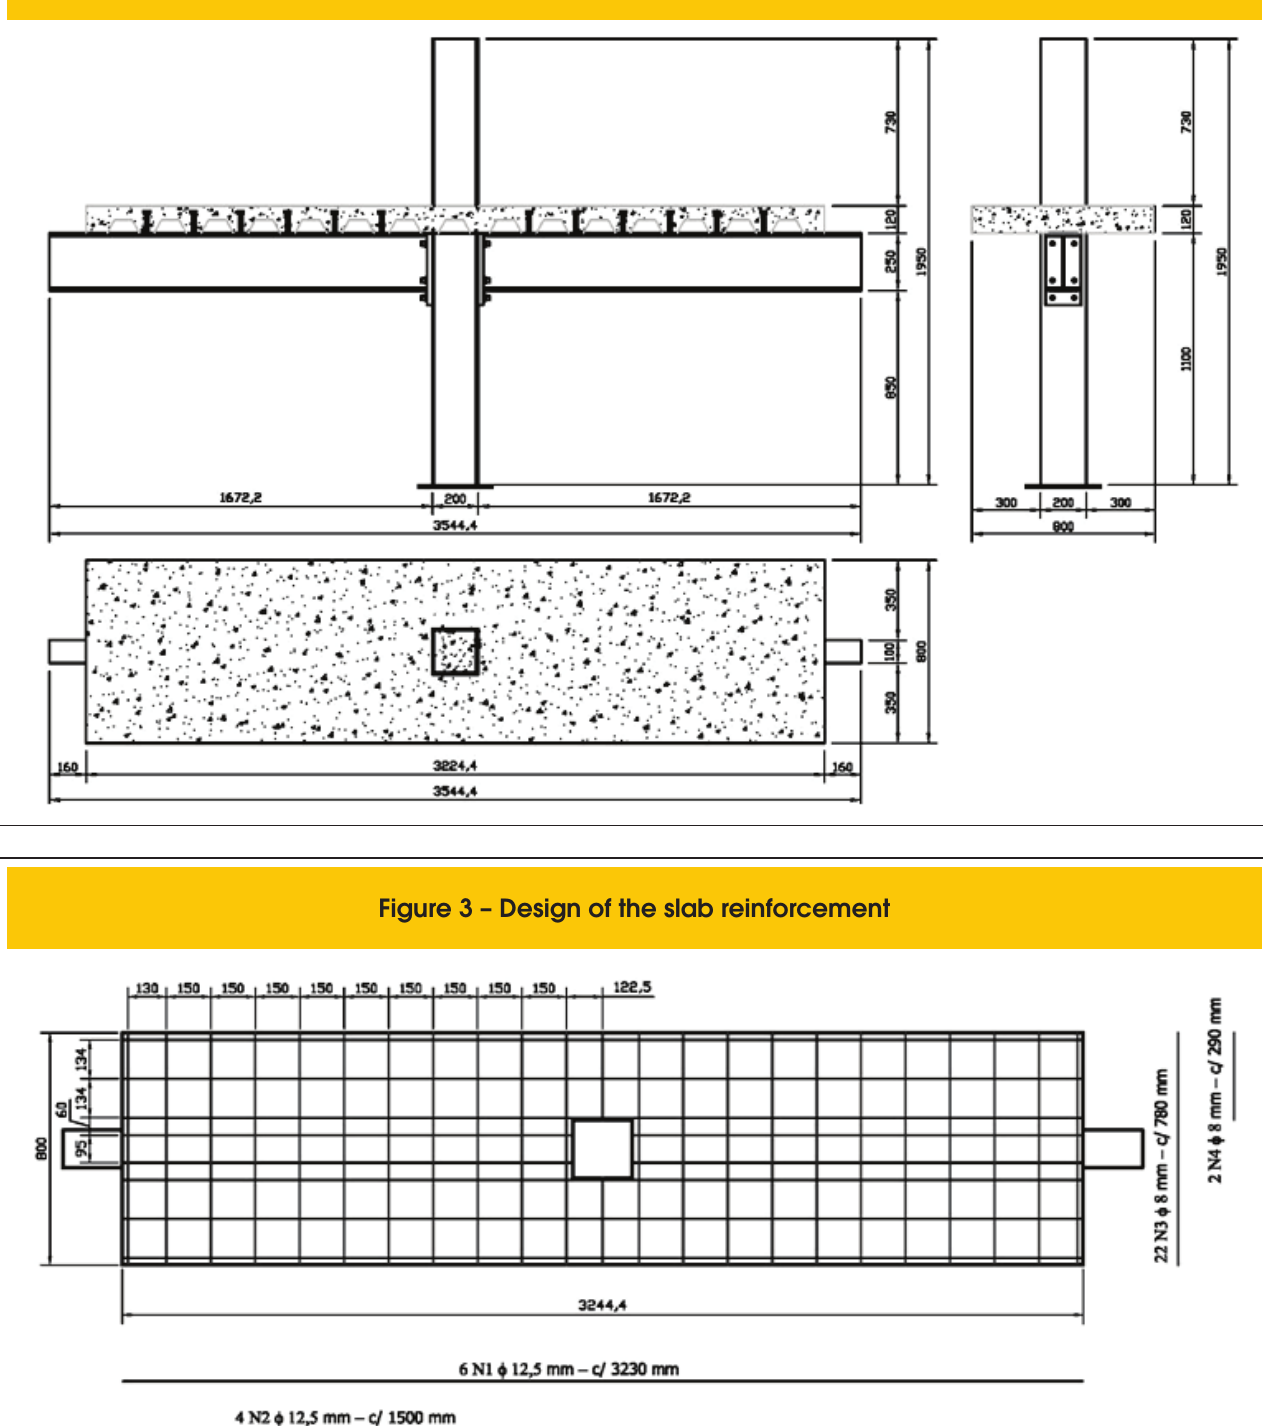
Figure 2 – Dimensions of the tested connection